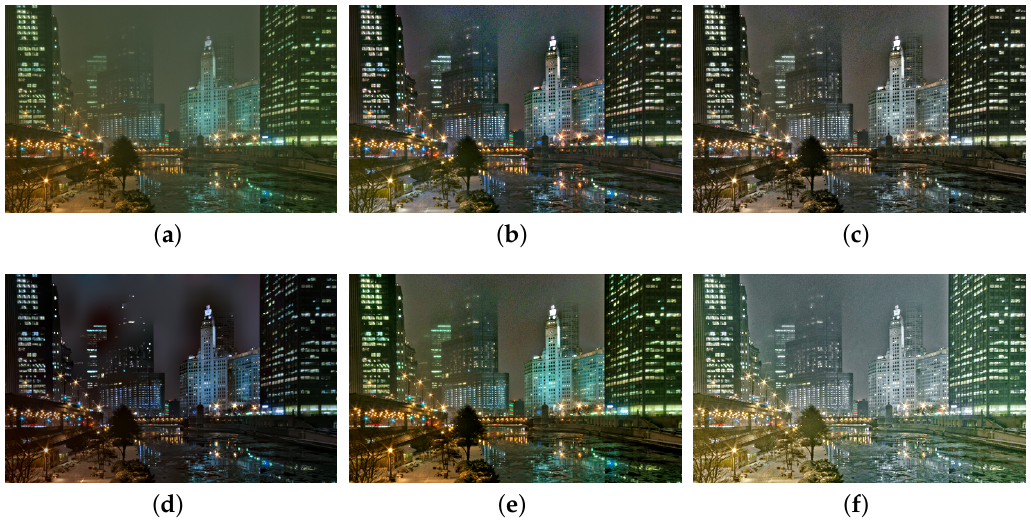
Figure 16. Comparisons with other nighttime dehazing methods on test image Building .